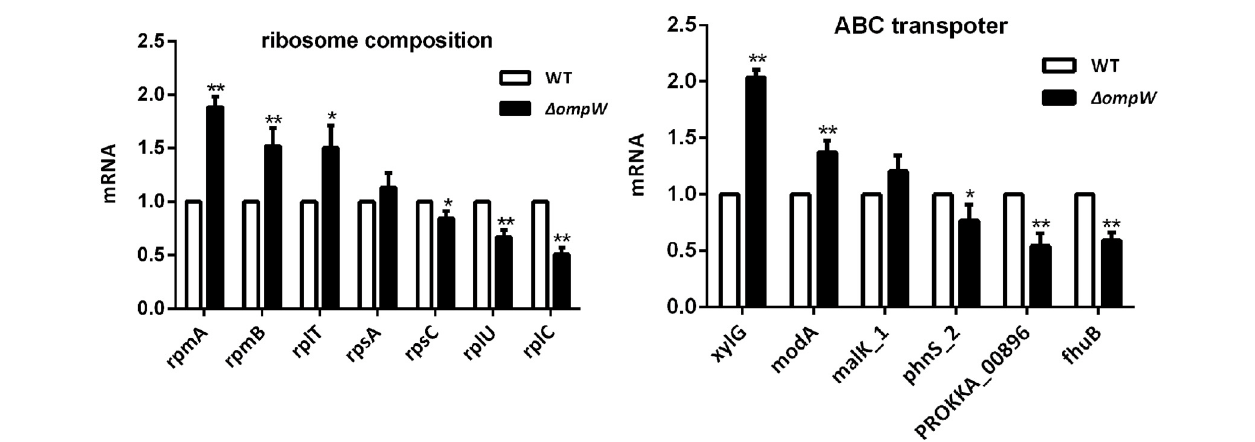
FIGURE 5 | RT-PCR determination of the expression levels of ribosome synthesis related genes and ABC transporter genes following ompW gene deletion. Total RNA was extracted from bacterial strains and reverse-transcribed to cDNA. Amplification of cDNA was carried out using SYBR Premix Ex Taq kit. The experiment has at least three biological repetitions. Results are expressed as means ± SD of three independent experiments. ‘*’ indicates significance at p < 0.05 and ‘**’ indicates significance at p <